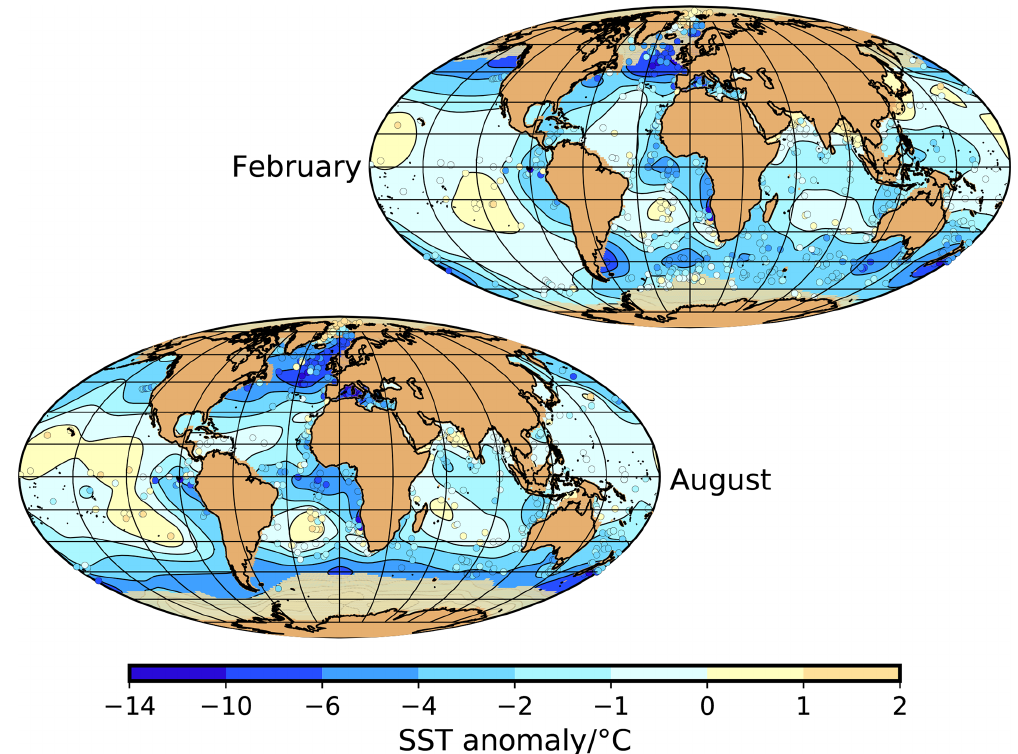
Figure 4. Analyzed LGM NSST anomalies for February and August (contour map) and data points (colored circles). In total, there are 600 data points for February and 464 data points for August (without the data points that are assumed to be covered by sea ice). The anomalies are relative to WOA (1998). The yellow–brownish areas close to Antarctica and in the Arctic indicate the LGM sea-ice masks based on the selected LGM sea-ice reconstructions.